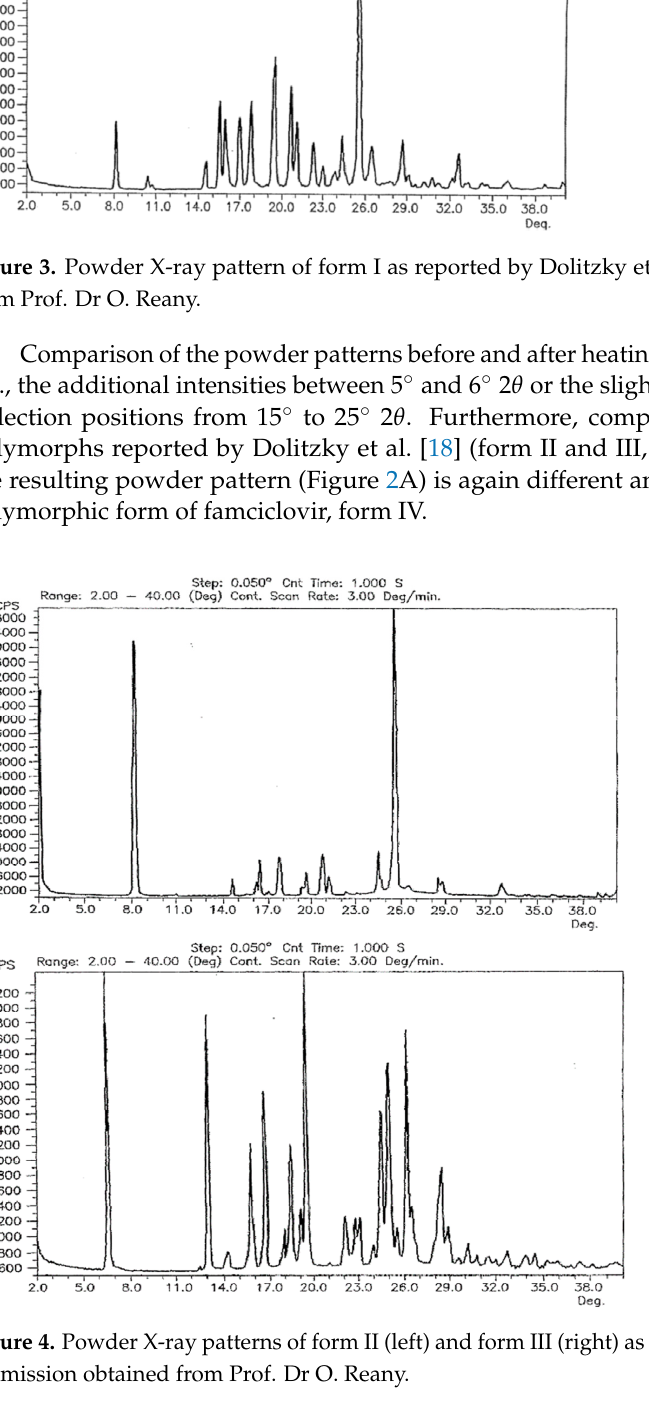
Figure 5. Structure determination of form IV is currently underway.